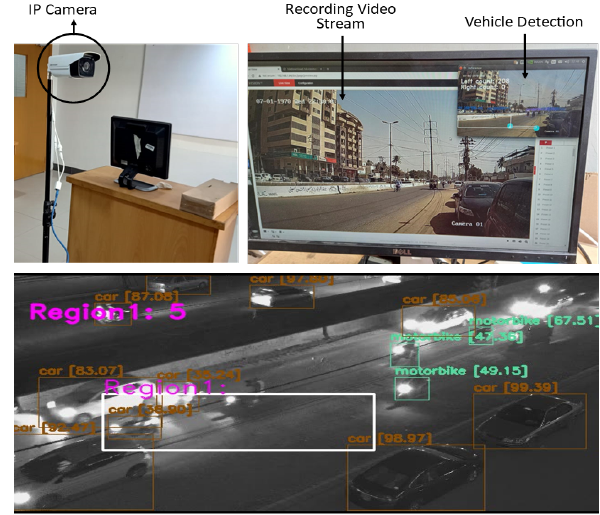
Figure 4. Camera setup for test video collection near ZUFESTM.